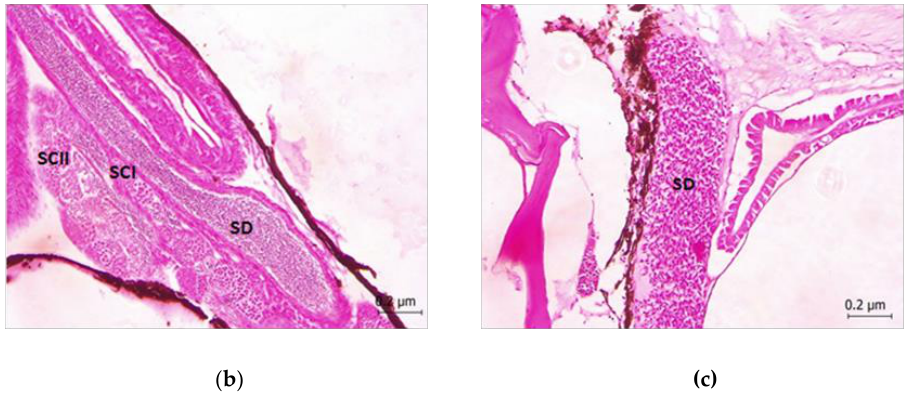
Figure 3. ( a ) Micrographs of dechlorinated water control treatment of Javanese medaka’s testis section (5 µ m) stained with H and E × 400. Seminiferous lobes containing germ cells: spermatogonia (SG), primary spermatocytes (SCI), secondary spermatocytes (SCII), spermatids (SD), spermatozoa (SZ). ( b ) Micrographs of 50 µ g / L of Diuron chronic exposure of Javanese medaka’s gonad section (testis) (5 µ m) stained with H and E × 400. Disorganization of the lobules and disintegration of the Sertoli cells. Seminiferous lobes containing germ cells spermatocytes (SCI), secondary spermatocytes (SCII), spermatids (SD). ( c ) Micrographs of 1000 µ g / L of Diuron chronic exposure of Javanese medaka’s gonad